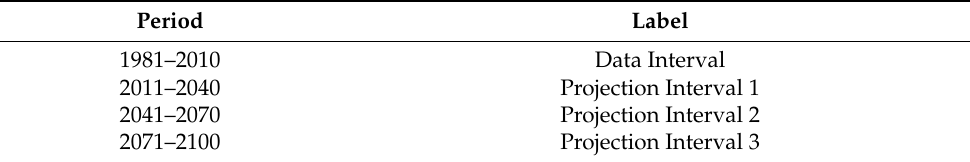
Table 2. Climate Normals intervals in framework simulations.